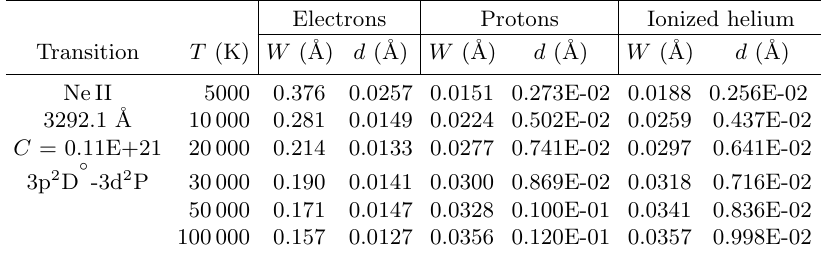
Table 1. Stark full widths at half intensity maximum ( W ) and shifts ( d ) due to electron, proton and ionized helium impacts for Ne II, for a perturber density of 10 17 cm − 3 . The quantity C (given in (cid:23)A cm − 3 ), when divided by the corresponding perturber width, gives an estimate for the maximum perturber density for which tabulated data may be used.